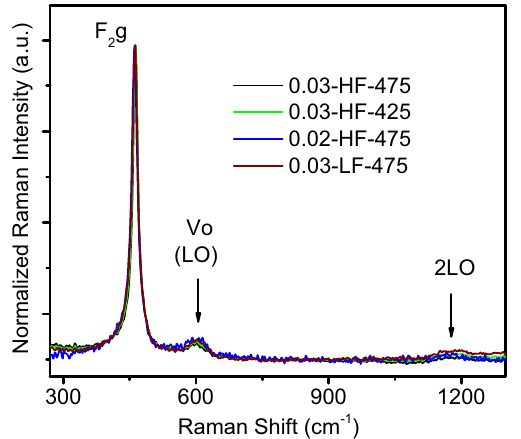
Figure 4. Raman spectra for the 0.03-HF-475, 0.03-HF-425, 0.02-HF-475, and 0.03-LF-475